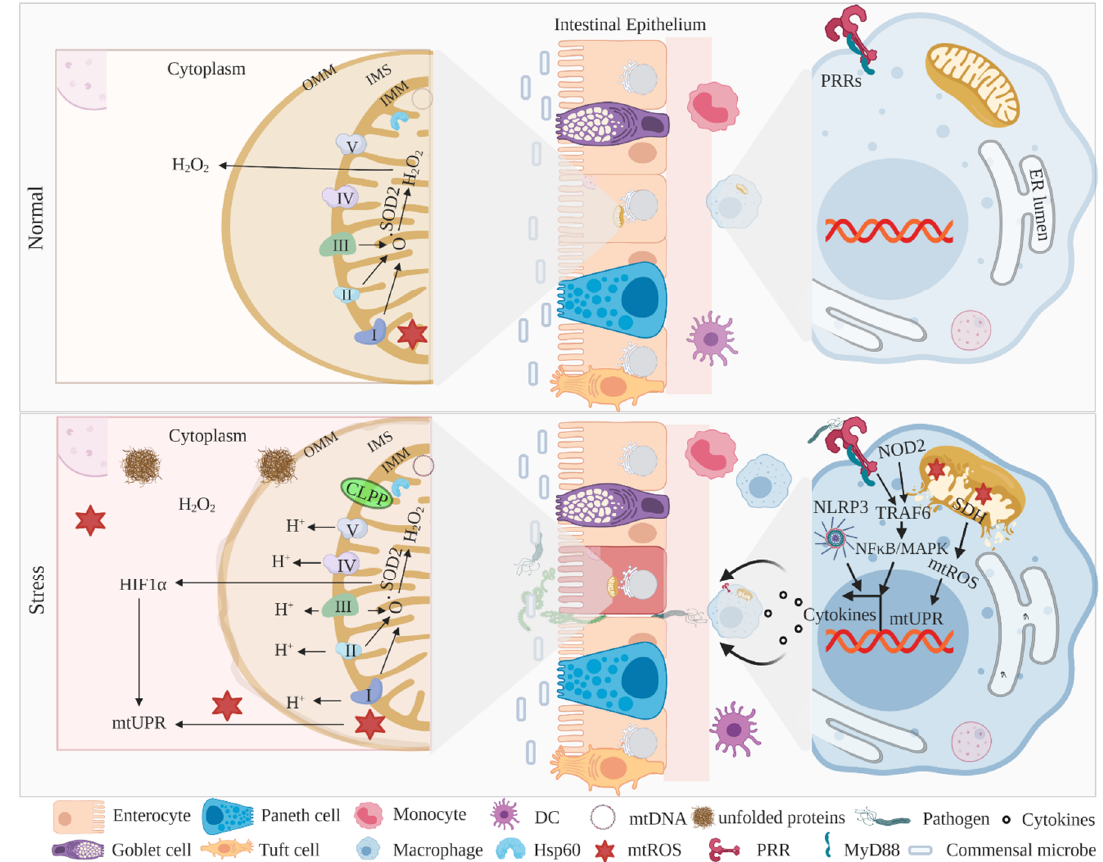
Figure 2. Mitochondrial-associated UPR signaling in IECs and myeloid cells. Mitochondrial ETC molecules (complex I, II, III, IV, and V) regulate ROS, superoxide, and ATP balance in IMM. The mitochondrial chaperon Hsp60 regulates protein-folding machinery in the mitochondrial matrix and maintains homeostasis; however, accumulation of unfolded proteins in the mitochondrial intermembrane space (IMS) induces mitochondrial ROS (mtROS) and superoxide signaling and coordinates with HIF1α to activate mitoUPR signaling. On the other side, the activated macrophage (right), in response to pathogen recognition, induces SDH activity to produce robust mtROS and restrict invading microbes and further NLRP3 inflammasome-mediated activation of proinflammatory IL-1β to restrict microbial growth. CLPP, caseinolytic mitochondrial matrix peptidase; HSP60, heat shock protein 60; IMM, inner mitochondrial membrane; IMS, inner mitochondrial space; MAPK, mitogen-activated protein kinase; OMM, outer mitochondrial membrane; PRRs, pathogen recognition receptors; ROS, reactive oxygen species; SDH, succinate dehydrogenase; SOD2, superoxide dismutase 2.